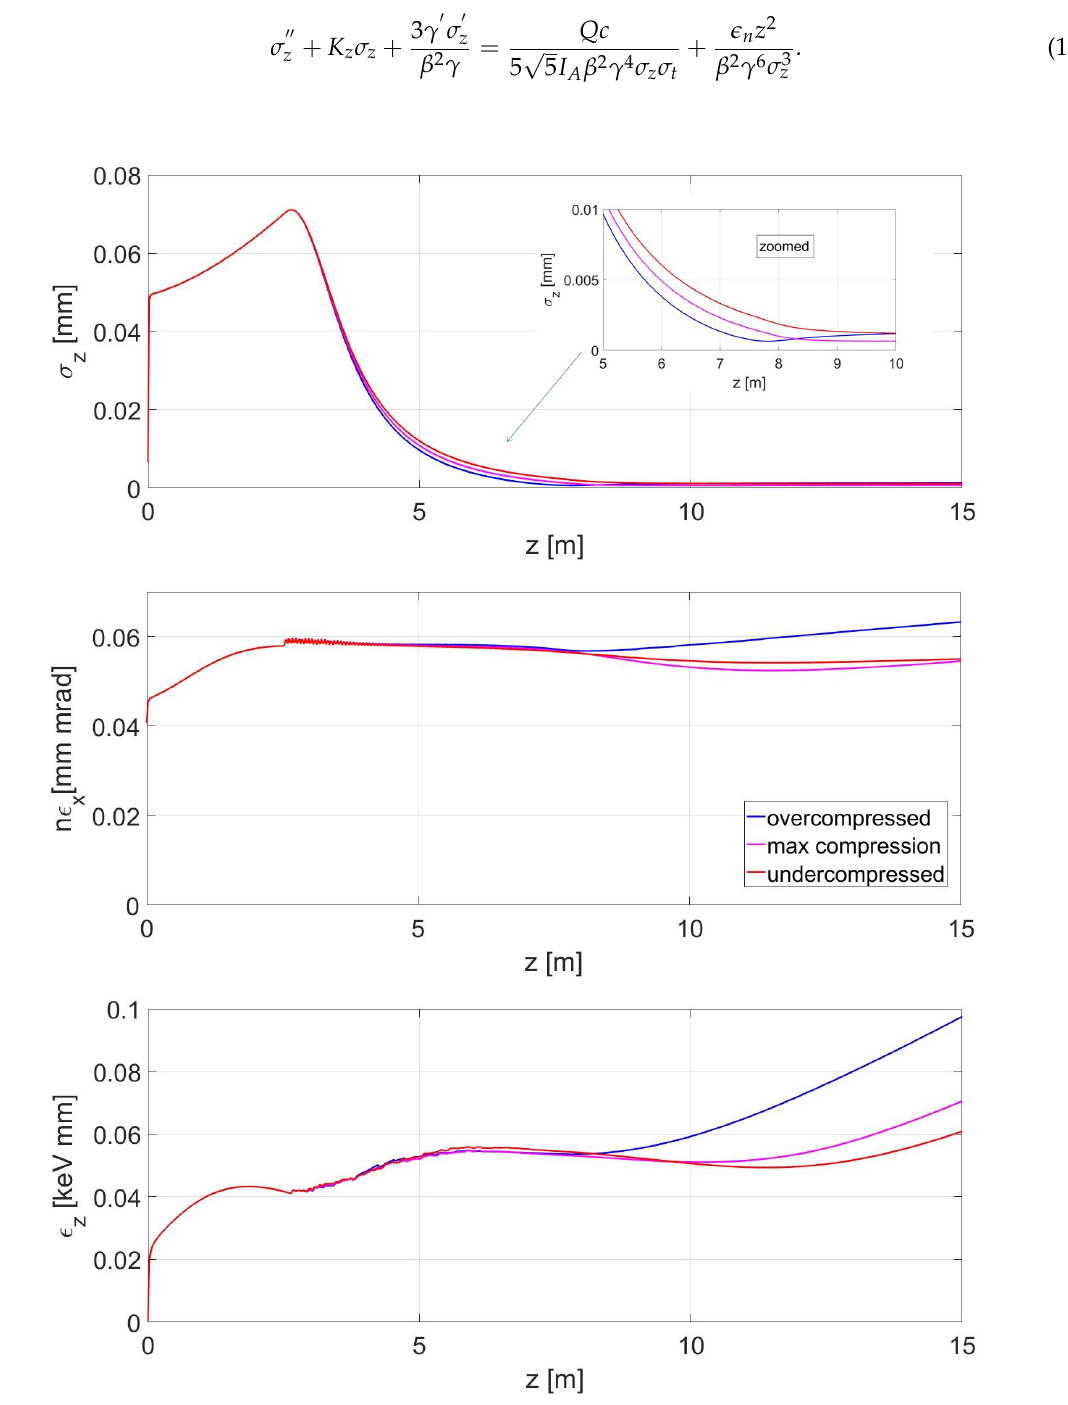
Figure 3. Example of compression with velocity bunching. Three cases are plotted corresponding to overcompression, maximum compression and undercompression respectively. It can be noted that as soon as the beam overcomes its maximum compression point (where we have slice-crossover) the transverse and longitudinal emittances start to rapidly increase. The simulations have been performed using the code ASTRA